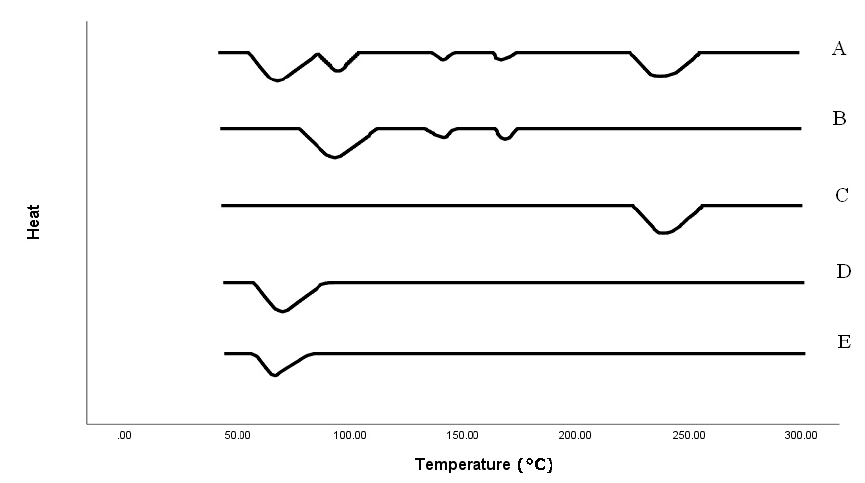
Figure 5. DSC thermograms of the (A) Formulation, (B) Drug, (C) Carbopol, (D) HPMC K4 and (E) HPMC K15.